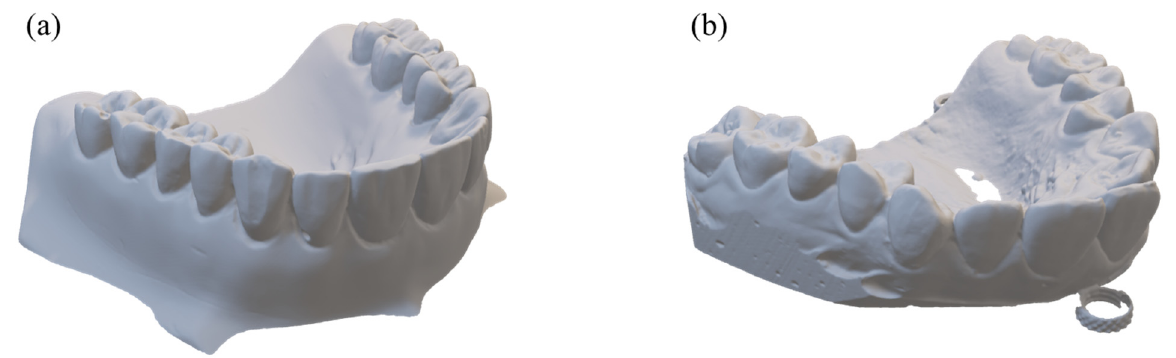
Figure 5. The plaster models, ( a ) Model 1 and ( b ) Model 2, in the STL format obtained from the optical scanning.